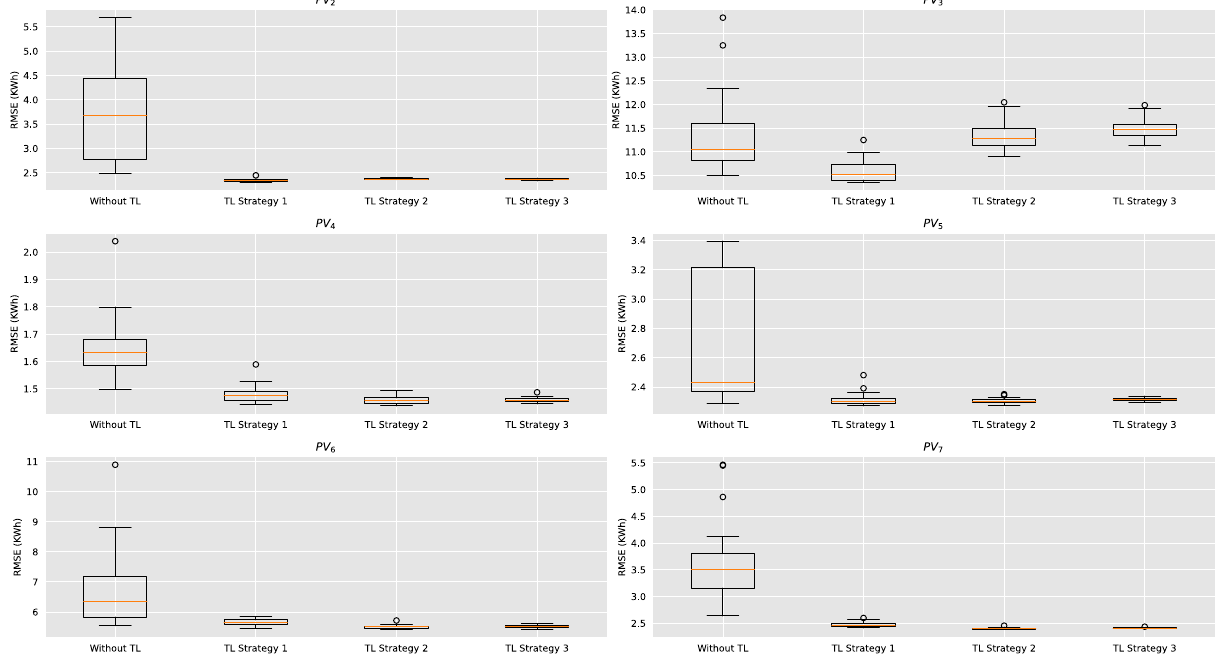
Figure 6. Boxplot that summarizes the performance of the four stacked LSTM models for the six target PV plants based on the RMSE. Base stands for the model that no TL has been applied, while TL1, TL2, TL3 stand for the three TL strategies,